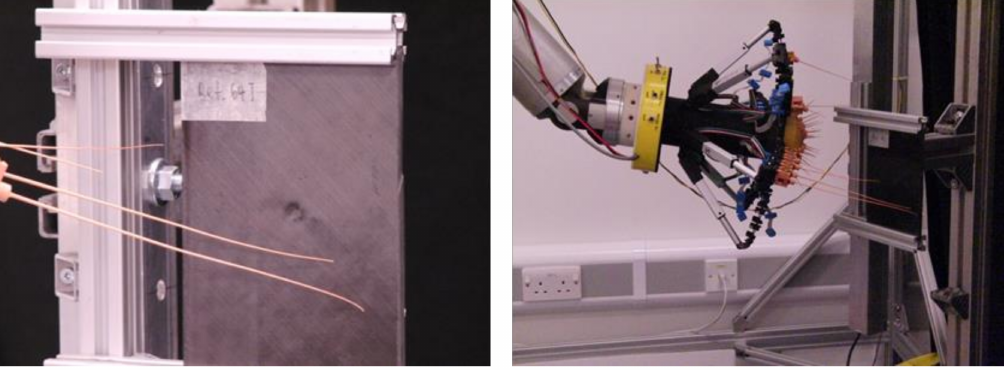
Figure 3. Whisker scanning set-up.